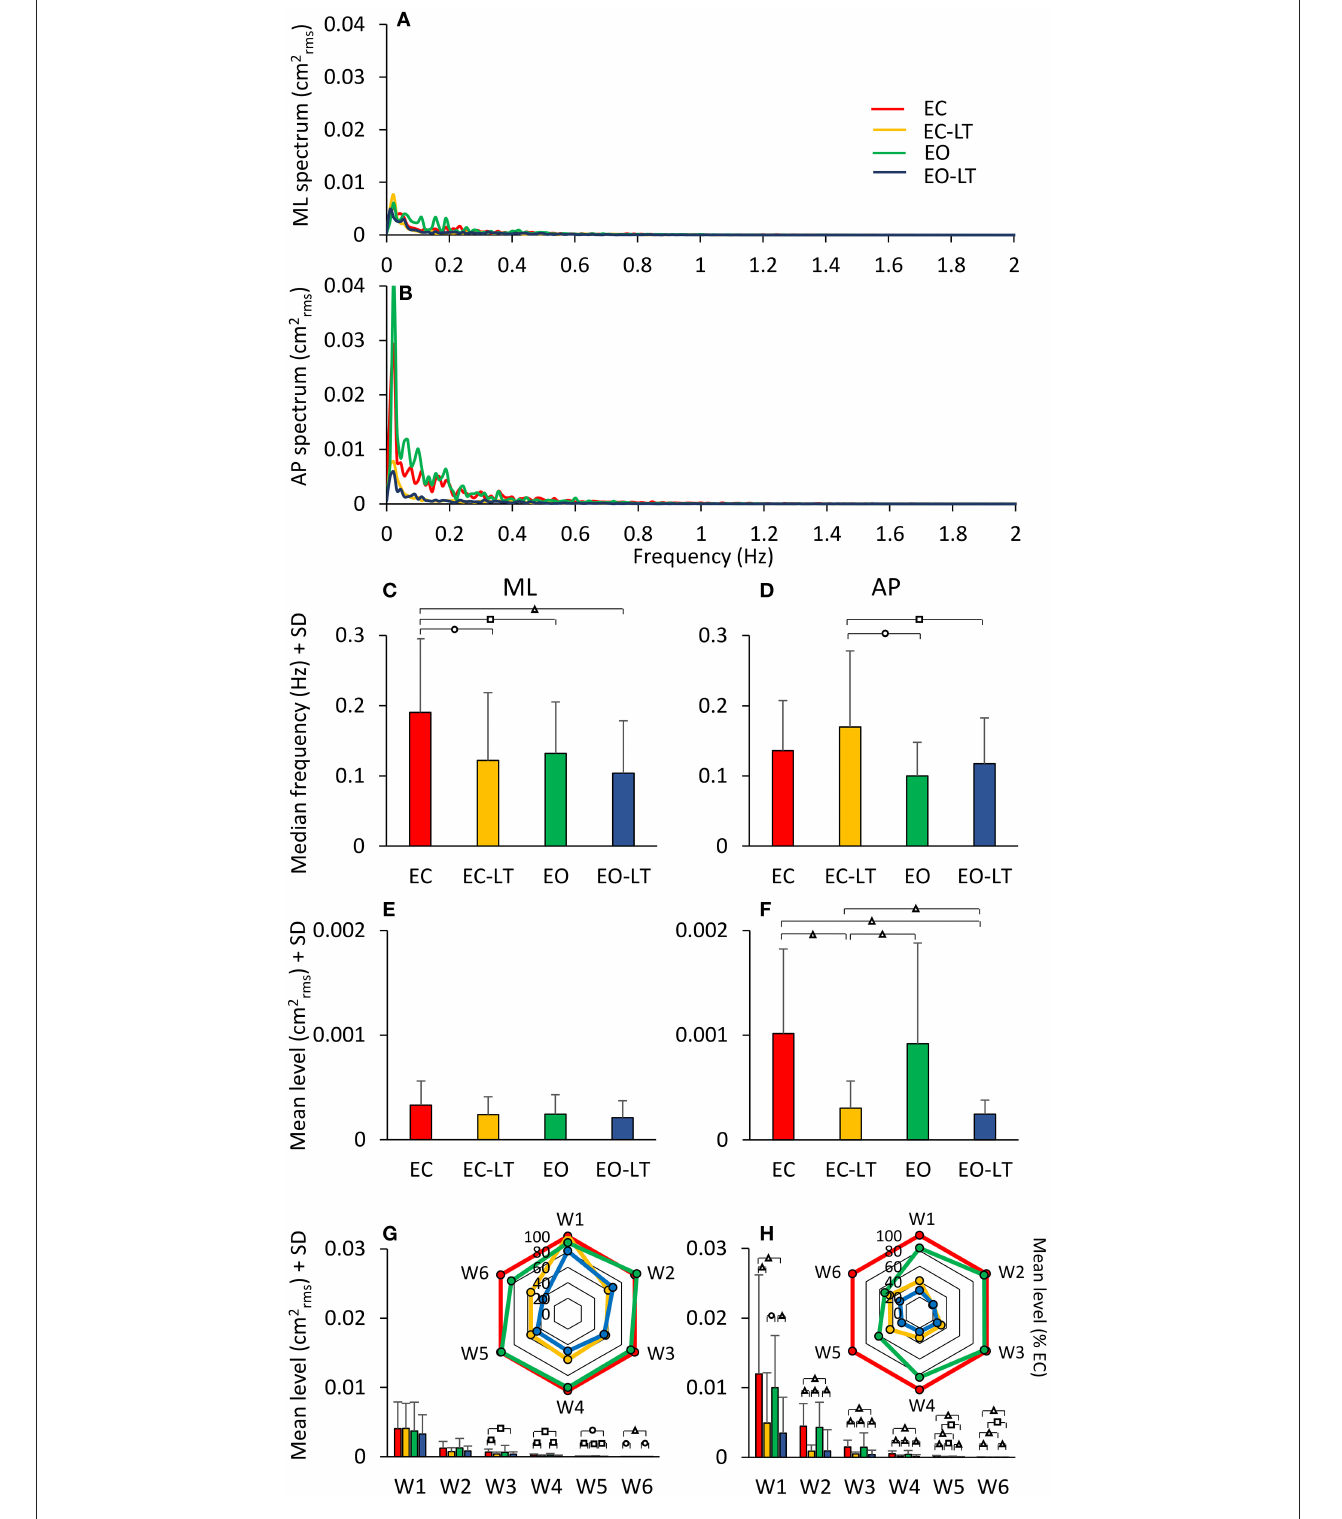
FIGURE 12 | Power spectrum on solid BoS. (A,B) compare the power spectra during quiet stance EC (red), EO (green), EC-LT (yellow), and EO-LT (blue). For the low-frequency range, the mean level with EO was not smaller than with EC (for both ML and AP directions). Touch (EC-LT) and vision (EO) produced the